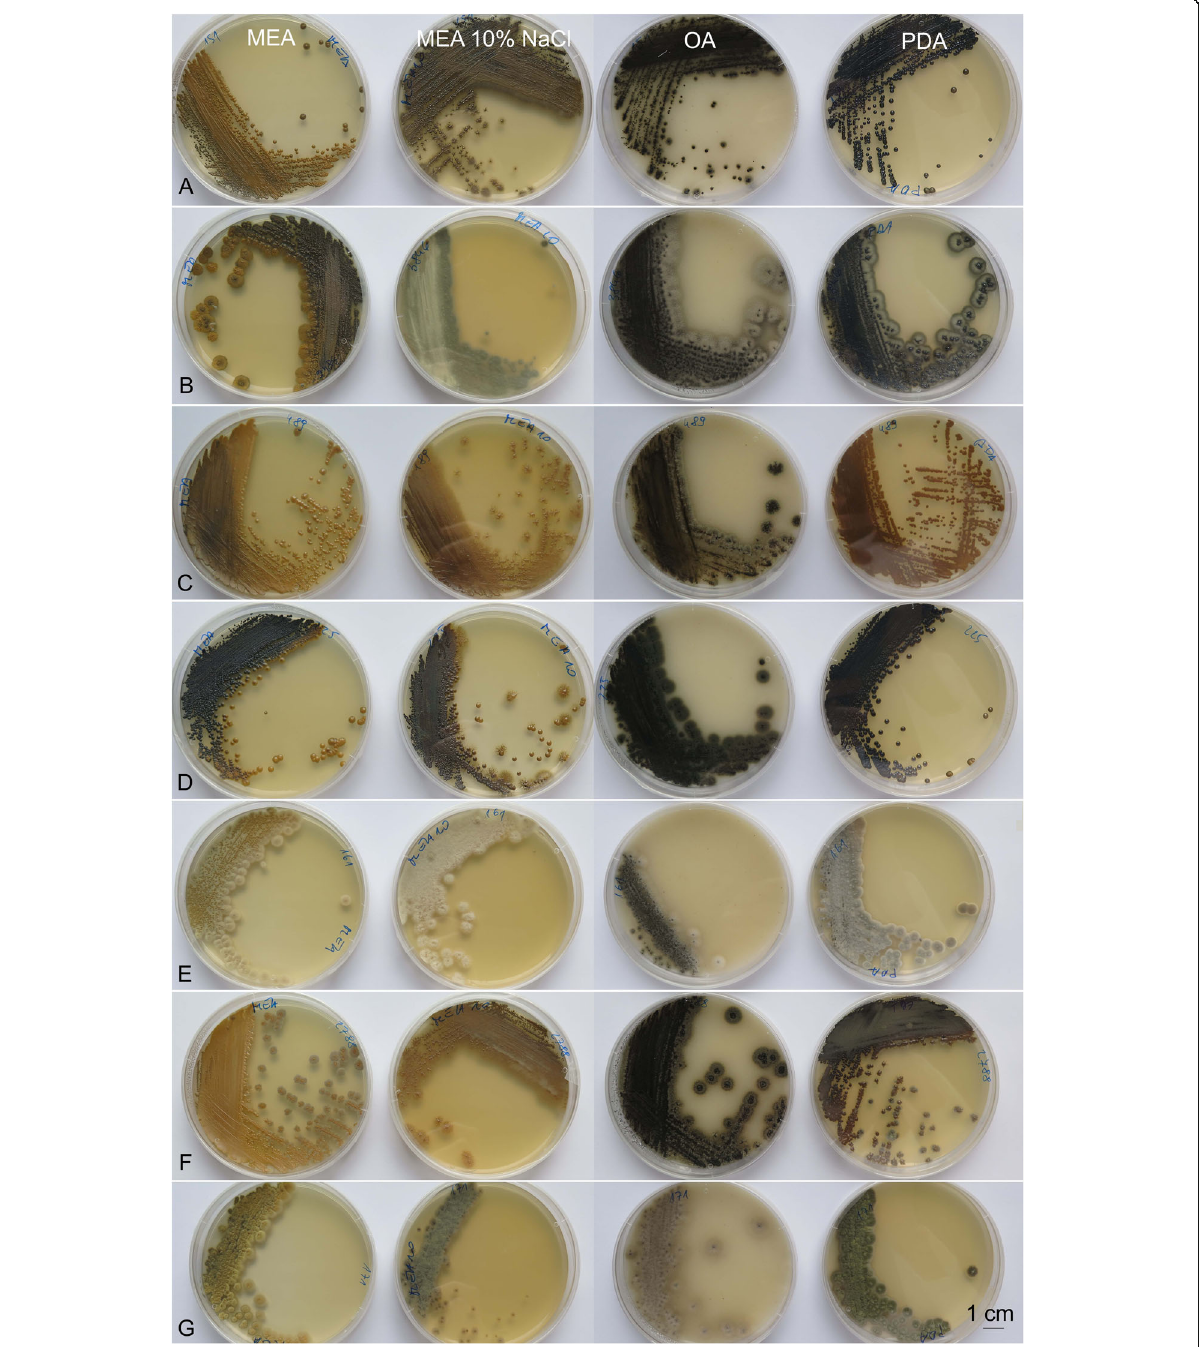
Fig. 9 Macromorphology of Hortaea werneckii strains grown on malt extract agar (MEA; column 1), MEA+ 10% NaCl (column 2), oatmeal agar (column 3) and potato dextrose agar (column 4), for 14 days at 25 °C. a EXF-151 T . b EXF-3846. c EXF-489. d EXF-225. e EXF-161. f EXF-2788. g EXF- 171. Bar = 1 cm (for